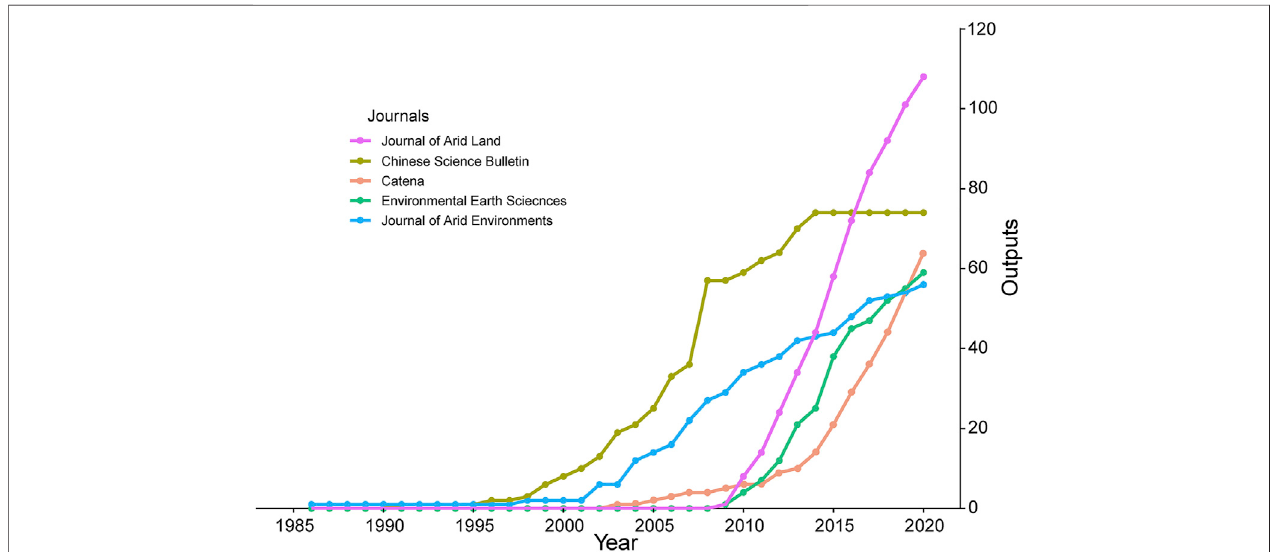
FIGURE 7 | The temporal trend of the top fi ve most productive journals that published papers on China ’ s deserts.